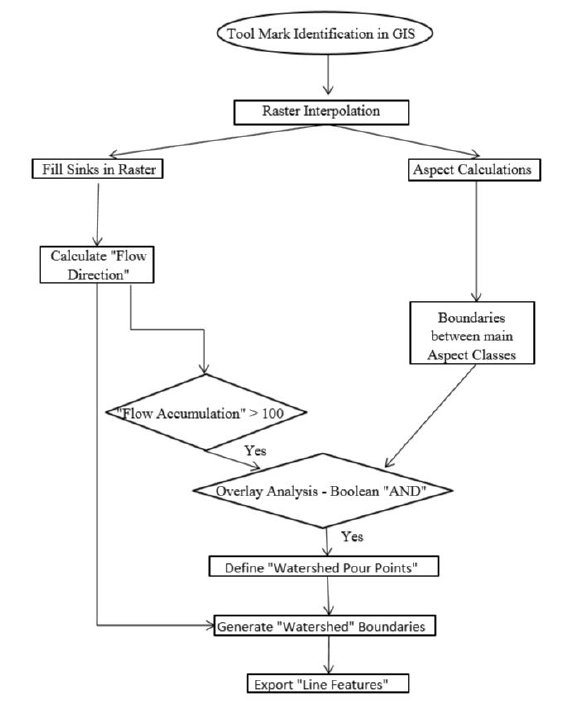
Figure 3. Flowchart of the automatic tool mark recognition in GIS